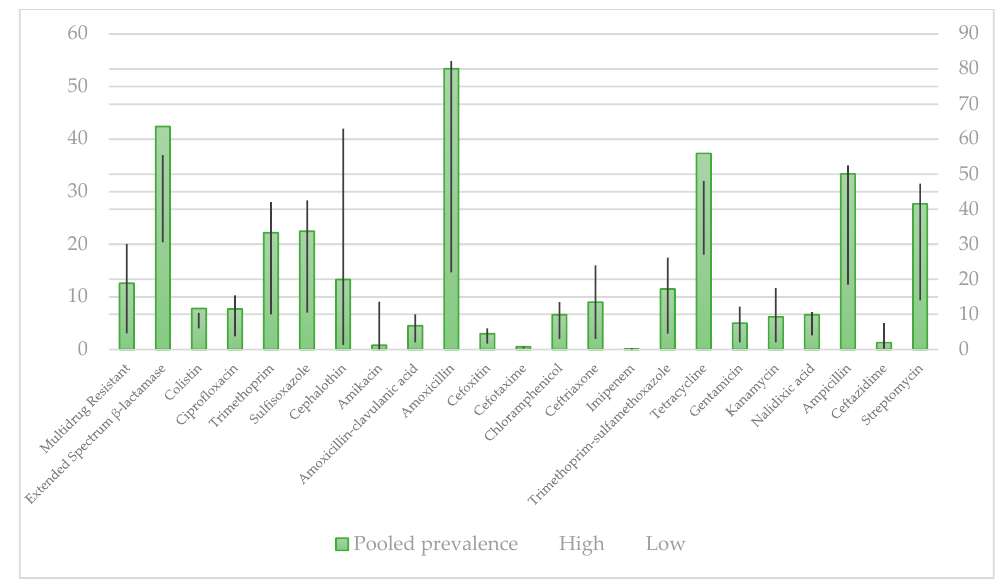
Figure 4. Pooled prevalence of antibiotic resistance isolates in humans by minimum inhibitory concentration, % [161].